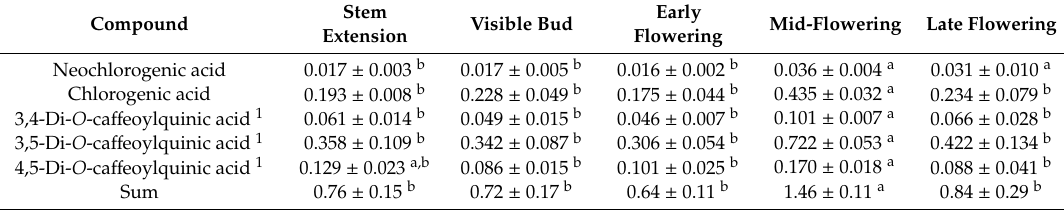
Table 4. Individual phenolic compound contents in the fresh matter (mg / g FM) of sunflowers at various growth